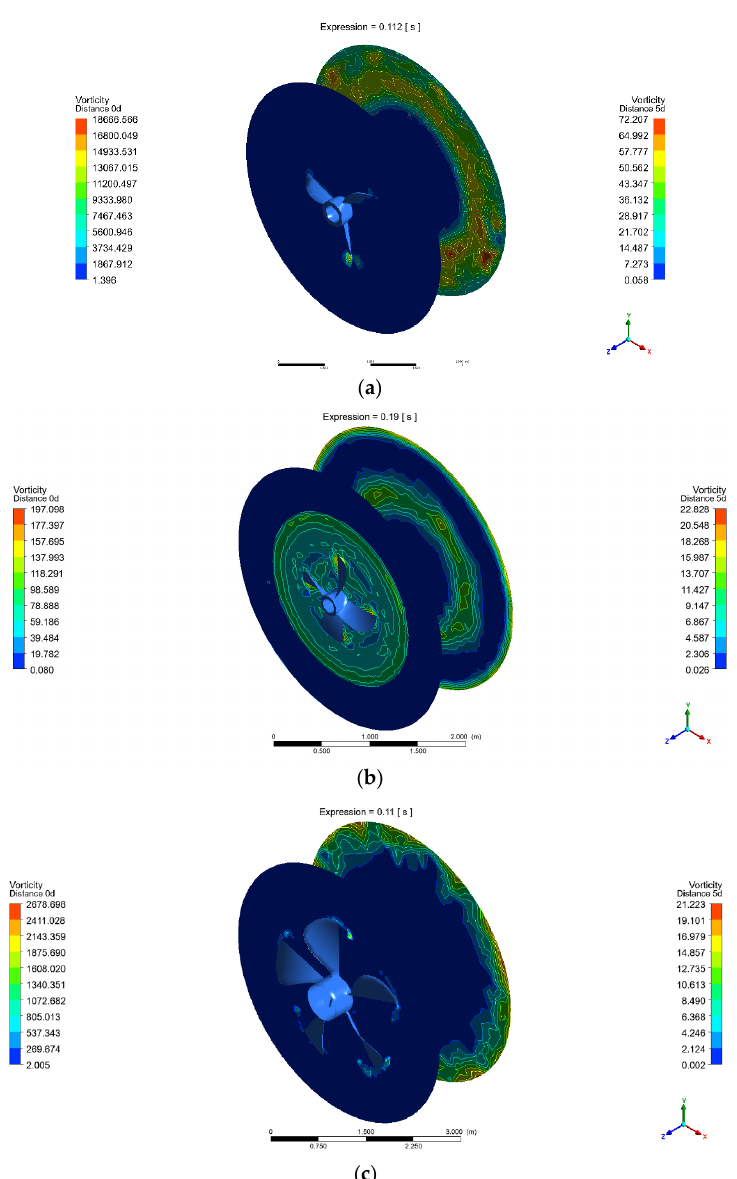
Figure 5. Vorticity magnitude in the vorticity region (i.e., tip-vortex region) as a source of sound on the blade and 5d downstream the propeller: ( a ) three blades, ( b ) four blades, and ( c ) five blades. Two systems of vortex structures make up the propeller’s wake and are primarily produced at the blade’s root and tip sections. The pressure difference between the blades’ face and back sides causes the tip vortices to form. Due to the non-constant circulation and axial hub vortex, a sheet of trailing vortices can be considered additional vortex struc- tures [24]. Higher relative fluid blade velocities, angular attack ranges, and more substantial vorticity sheds take precedence. The separation becomes dominant at higher harmonics with the help of displaced fluid—the spread of the signal and noise. The four-blade pro- peller’s higher noise level indicates the most increased fluid blade fluctuations and angle of attack variations. 4.2. Cavitation The wake’s presence significantly impacts the propellers’ cavitation and noise per- formance. The tip-vortex cavitation and leading-edge suction-side sheet cavitation are present and can be used to predict radiated noise levels. This can be performed for all propeller geometries. The results, therefore, are shown in Figure 6. (a)